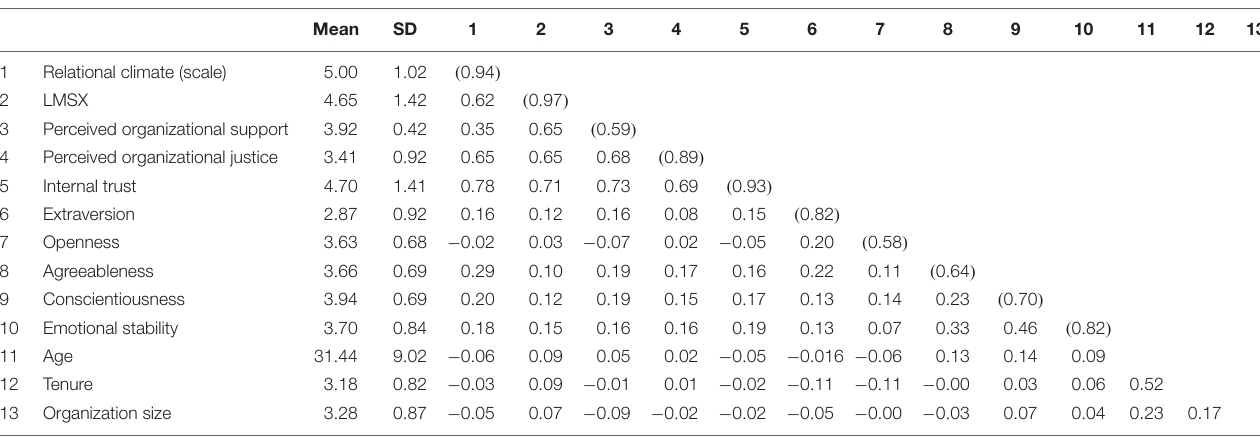
TABLE 9 | Correlation matrix for Study 3—antecedents 1 ( N =